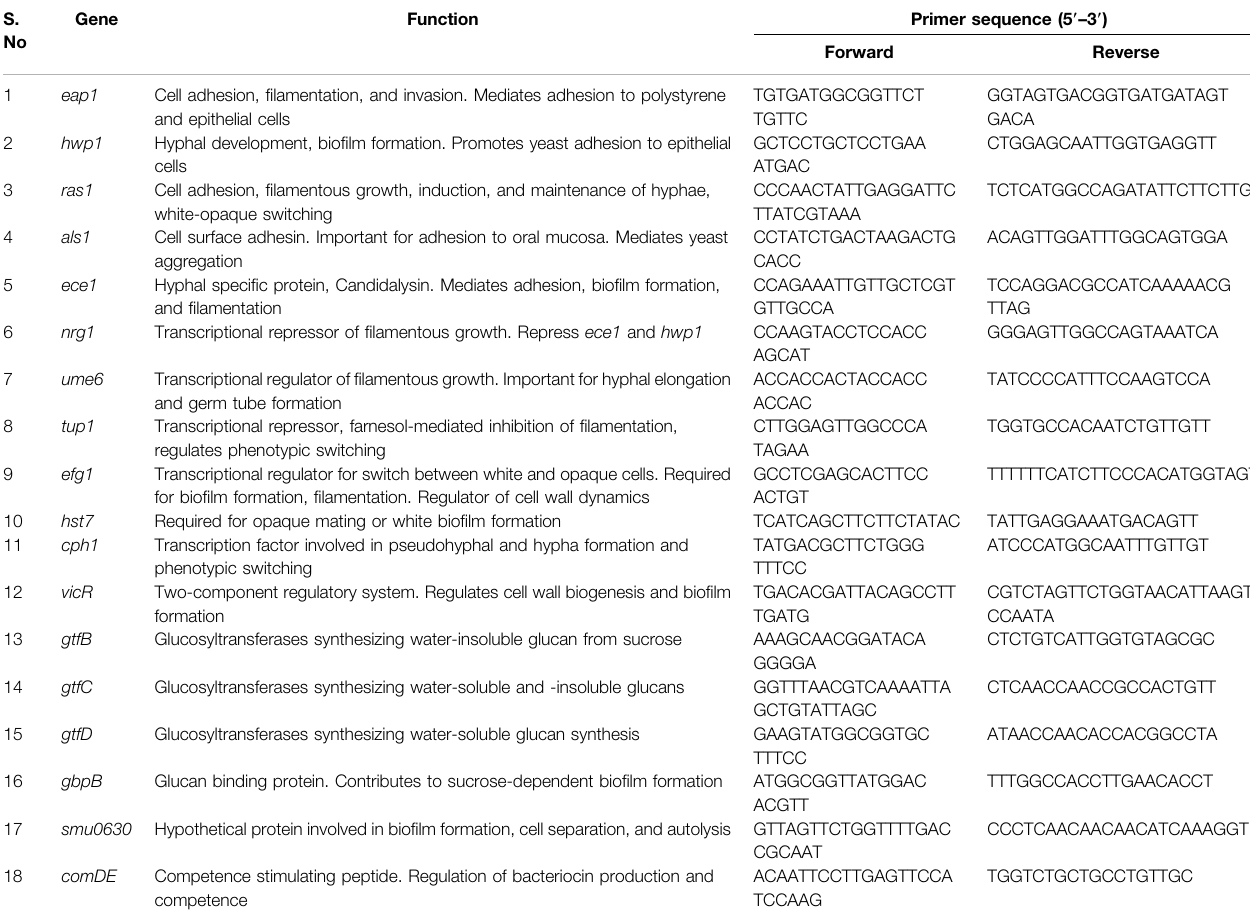
TABLE 1 | List of candidate genes, their role in virulence, and pathogenicity and primer details. S.